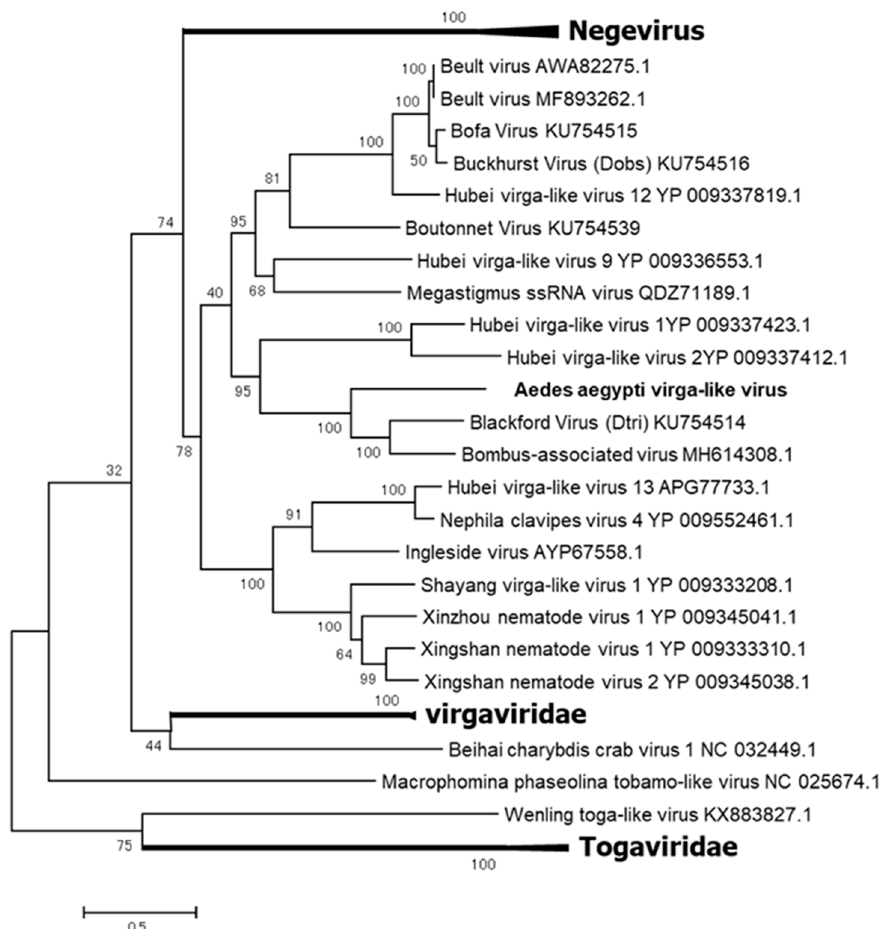
Figure 11. Phylogenetic analysis of Aedes Aegypti virga-like virus (AaVV). Maximum likelihood tree constructed with the complete amino acid domain of the genome sequence with Genbank accession number LC496783. The amino acid domain was aligned using the MAFFT 7 online version [27]. Bootstrap support values from 1000 bootstrap replicates are indicated on the branches.